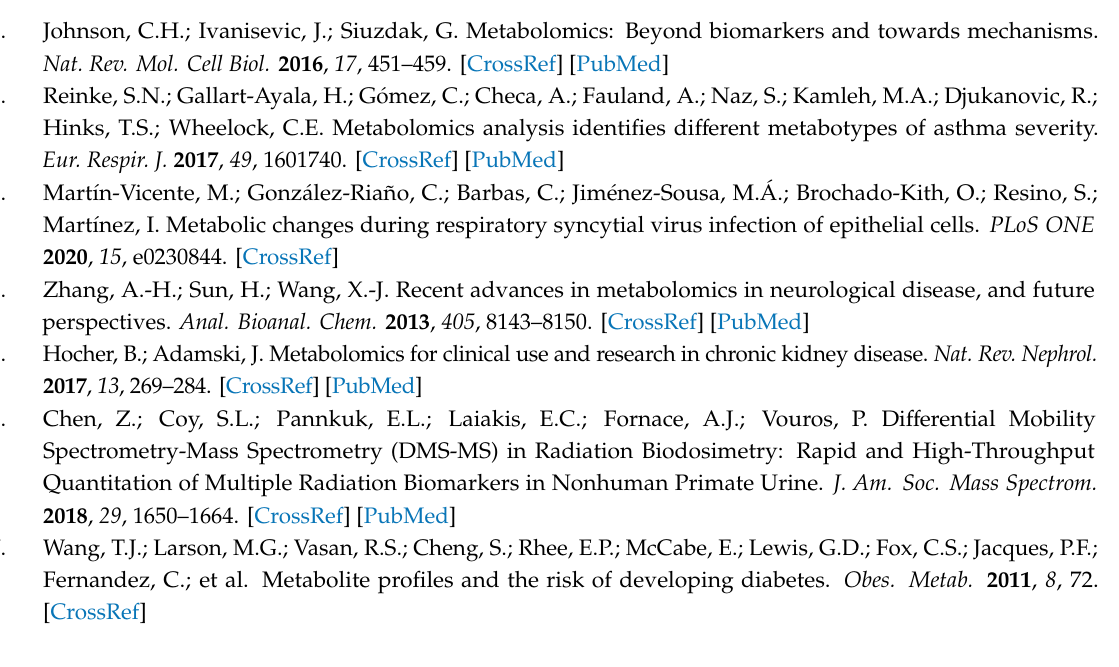
Table S1. List of detected compounds with the combined approach of Lipid Data Analyzer and Compound Discoverer 3.1; Table S2. List of parameters used for data processing with XCMS online (version of XCMS online 2.7.2, XCMS 1.47.3, CAMERA 1.34.0); Figure S1. Increase of statistical power with the LDA approach. Compounds with confident level 1 found in CSF and Plasma samples with all three data processing workflows: Compound Discoverer 3.0 (CD), XCMS, and the combined approach with CD and Lipid Data analyzer 2.6 (LDA). ns: p > 0.05, *: p ≤ 0.05, **: p ≤ 0.01. ***: p ≤ 0.001, ****: p ≤